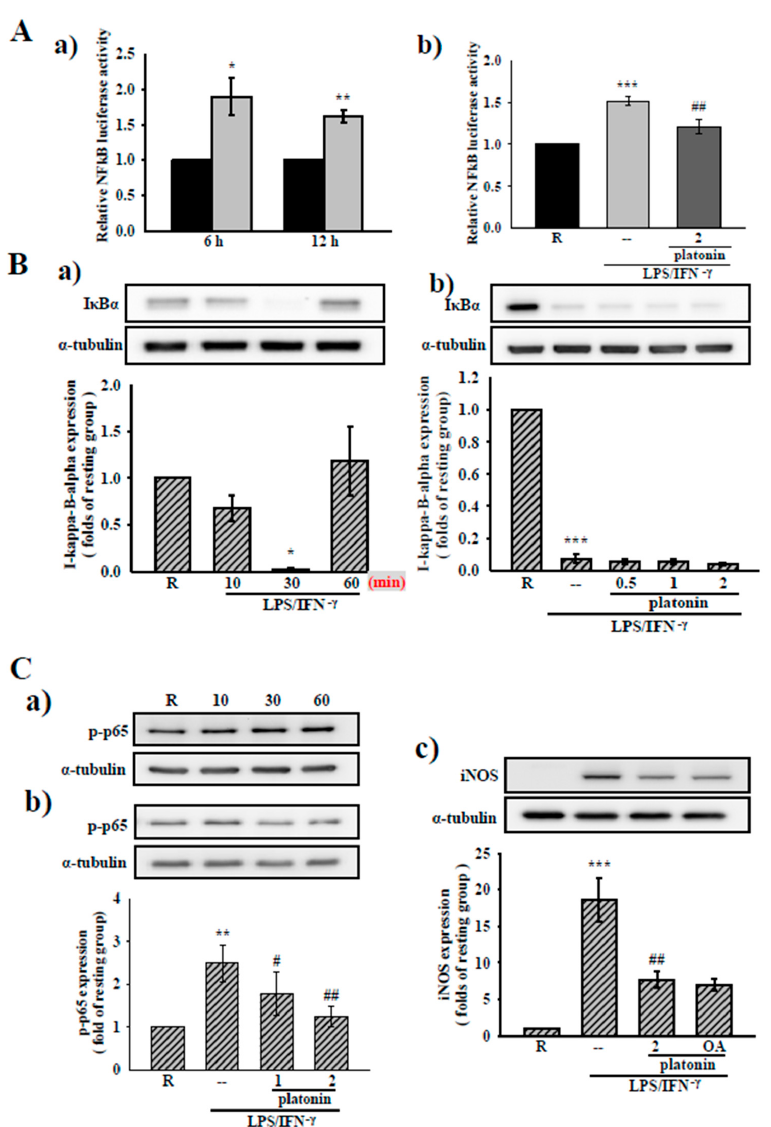
Figure 3. Effects of platonin on the Nuclear factor kappa-light-chain-enhancer of activated B cells (NF- κ B) signaling pathway in vascular smooth muscle cells (VSMCs) stimulated by LPS/IFN- γ . ( A ) After transient transfection with NF- κ B-luc and Renilla-luc plasmids for 24 h, the VSMCs were administered without ( a ) or with ( b ) platonin (2 µ M) for 30 min then stimulated by the combination of LPS (50 µ g/mL) and IFN- γ (100 units/mL; LPS/IFN- γ ) for 6 h or 12 h (black bar: resting group; gray bar: LPS/IFN- γ -treated group; deep-gray bar: platonin + LPS/IFN- γ -treated group). A luciferase assay was conducted as described in “Materials and Methods.” ( B ) ( a ) Cells were treated with LPS/IFN- γ for the indicated period. ( b ) Cells were pretreated with platonin (0.5–2 µ M) for 30 min before treatment with LPS/IFN- γ for another 30 min. ( C ) Cells were pretreated without ( a ) or with platonin (1 µ M or 2 µ M) ( b ) or okadaic acid (10 nM) + platonin (2 µ M) ( c ) for 30 min, then treated with LPS/IFN- γ for the indicated time ( a ), 30 min ( b ), and 24 h ( c ). The extent of I κ B α phosphorylated p65, and inducible nitric oxide synthetase (iNOS) were determined using Western blotting assay. Data are represented as mean ± S.E.M. ( n = 3); * p < 0.05, ** p < 0.01, *** p < 0.001 compared with the resting (R) group; # p < 0.05, ## p < 0.01 compared with the positive control